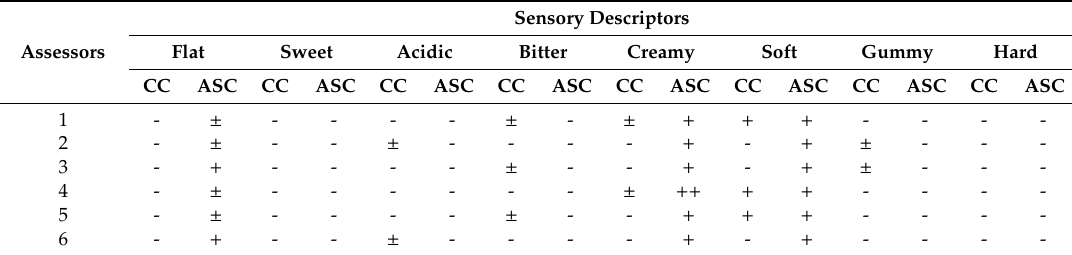
Table 5. Comparison between taste (flat, sweet, acidic, and bitter) and texture (creamy, soft, gummy, and hard) attributes of two-month-ripened Caciotta cheese samples with (ASC) and without (control cheese, CC) autochthonous starter